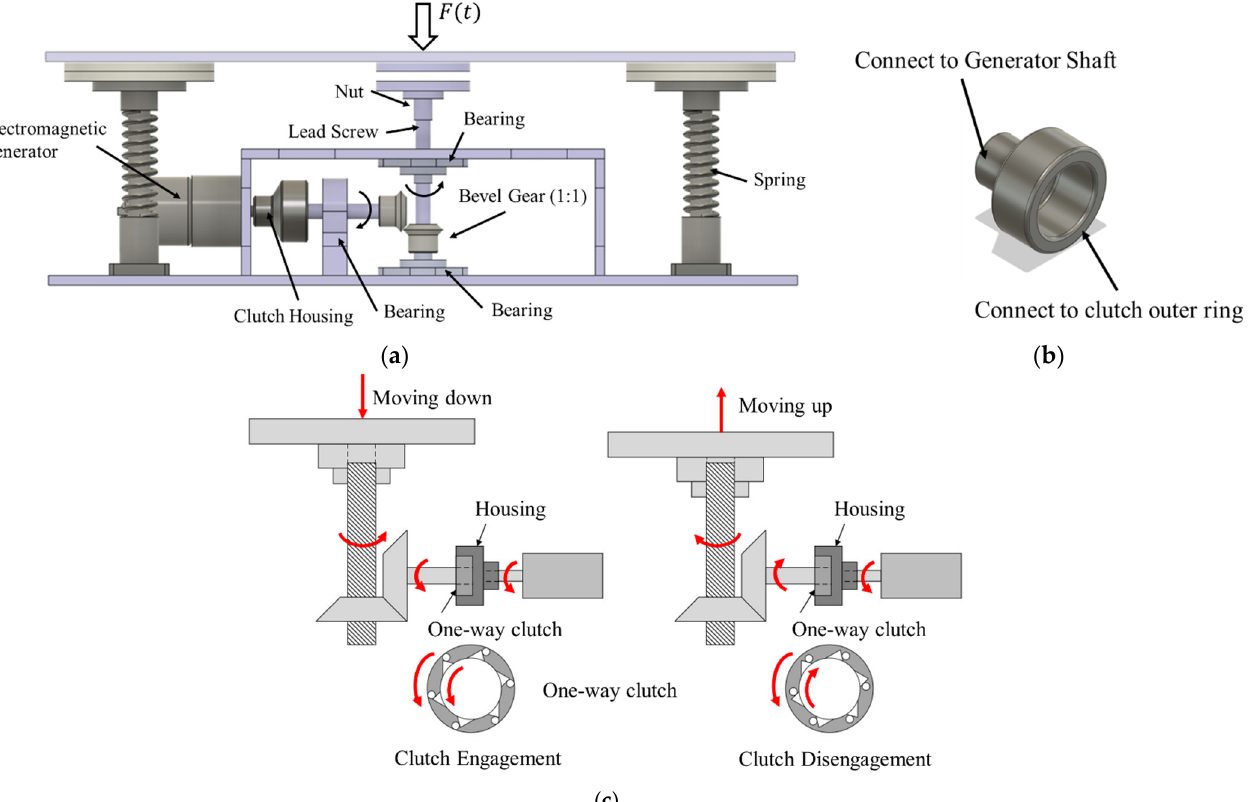
Figure 1. The design of kinetic-energy harvesting floor with the one-way clutch mechanism: ( a ) schematic diagram of Genpath V2 design; ( b ) clutch housing; ( c ) function of the one-way clutch mechanism.